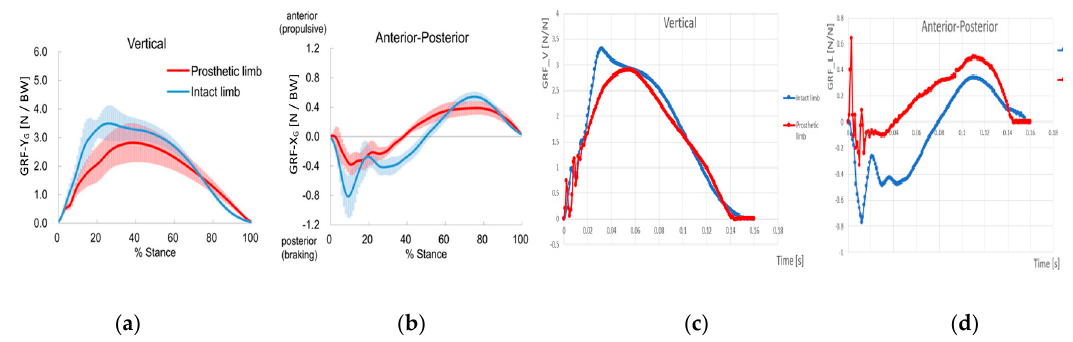
Figure 4. GRF components in the Global Reference Frame for Elite sprinters: Literature data and present study: ( a , b) GRF in the vertical Y G and horizontal X G direction for the intact (blue) and affected (red) limb as in [6], ( c , d ) GRF in the vertical and horizontal direction from athlete